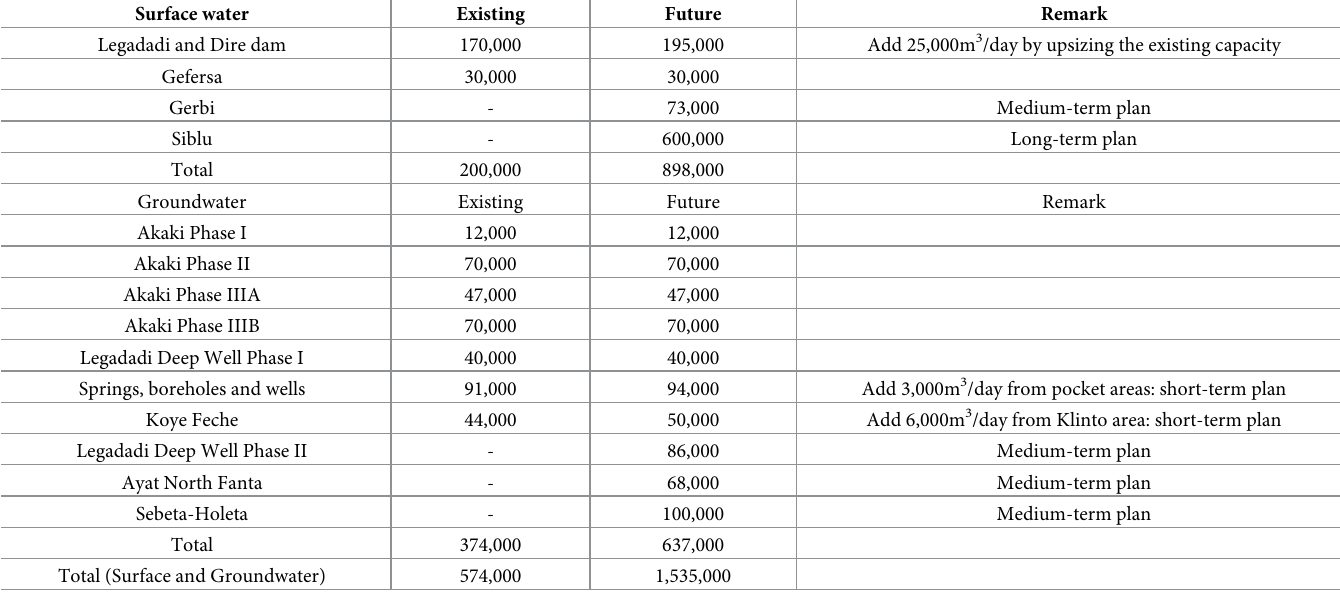
Table 1. Existing and future water supply capacity (m 3 /day) from surface water and groundwater source. Surface